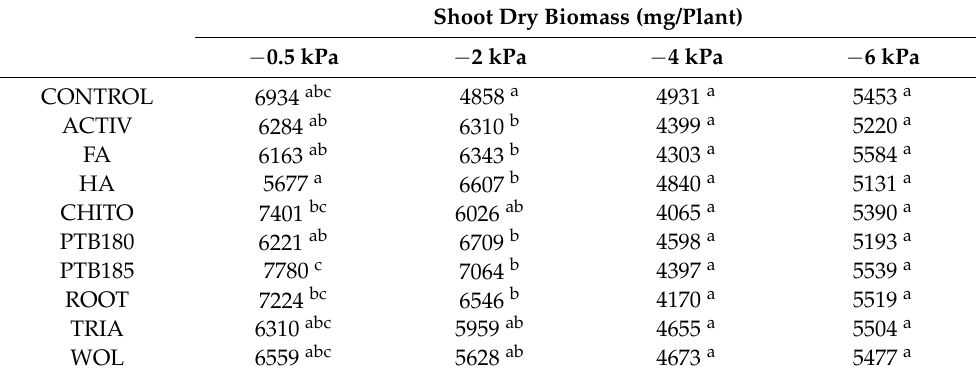
Table 10. Effect of biostimulants and substrate water potentials on the shoot dry biomass of Batavia lettuce under organic